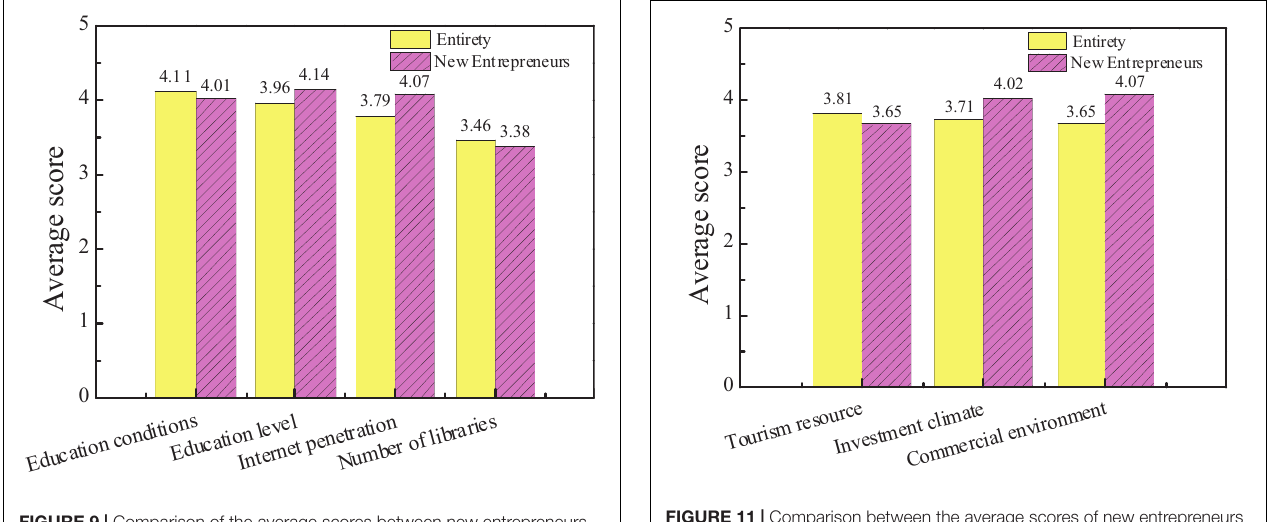
FIGURE 9 | Comparison of the average scores between new entrepreneurs and the overall audience.